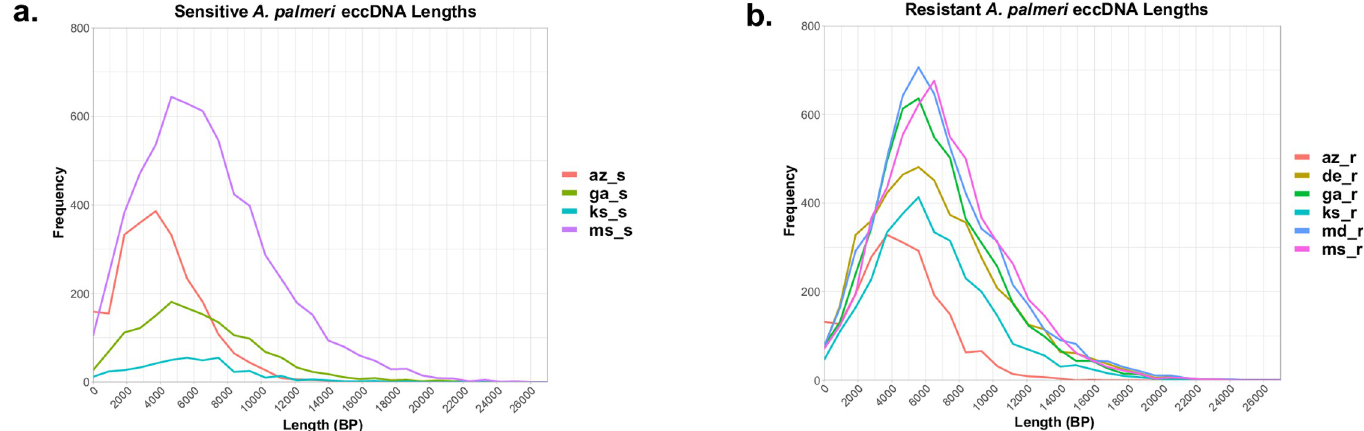
Fig 1. Frequency polygon graph for Lengths (bp) of A . palmeri eccDNAs. A) Glyphosate sensitive samples were sourced from Arizona (az_s), Georgia (ga_s), Kansas (ks_s), and Mississippi (ms_s) A. palmeri plants. B) Glyphosate resistant samples were sourced from Arizona (az_r), Delaware (de_r), Georgia (ga_r), Kansas (ks_r), Maryland (md_r), and Mississippi (ms_r)